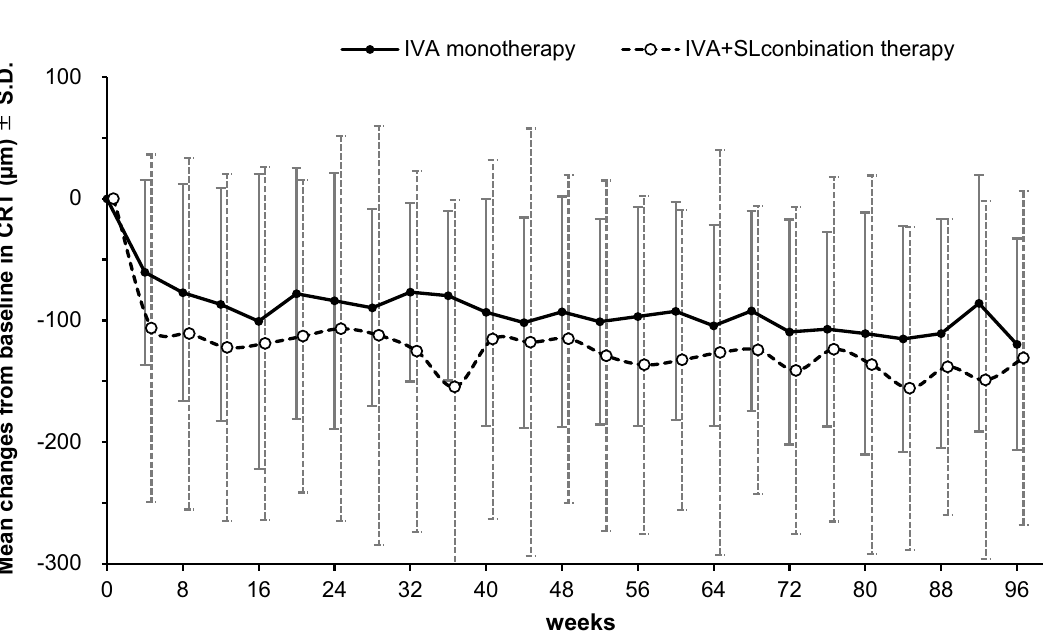
Figure 3. Mean changes of CRT from baseline in the IVA monotherapy group and IVA + SL combination therapy group. IVA intravitreal aflibercept; SL subthreshold laser; CRT central retinal thickness. SD standard